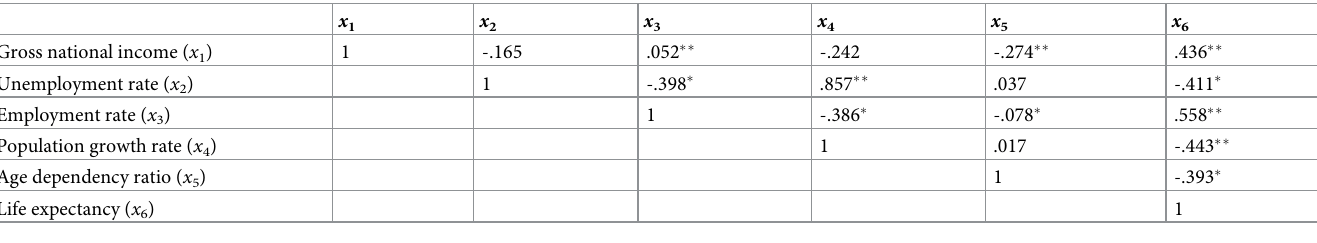
Table 3. Pearson correlation coefficient between variables.